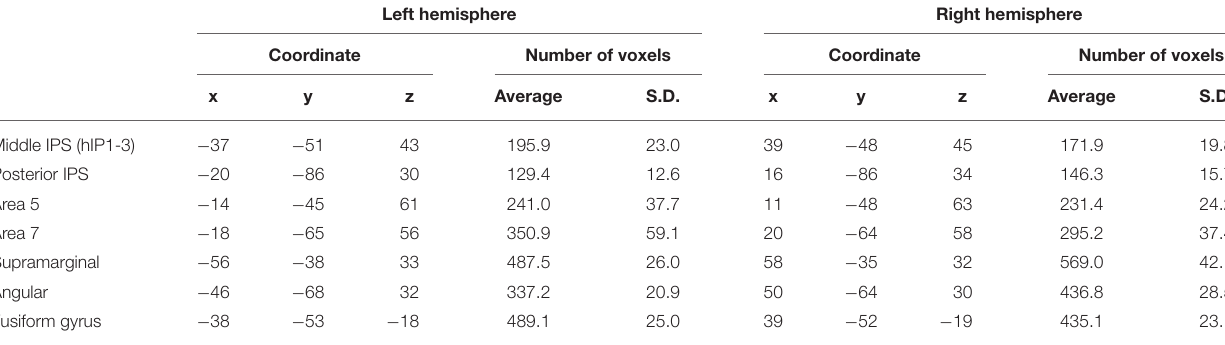
TABLE 2 | Mean coordinate and number of voxels (voxel size 3 × 3 × 3 mm 3 ) for each VOI.